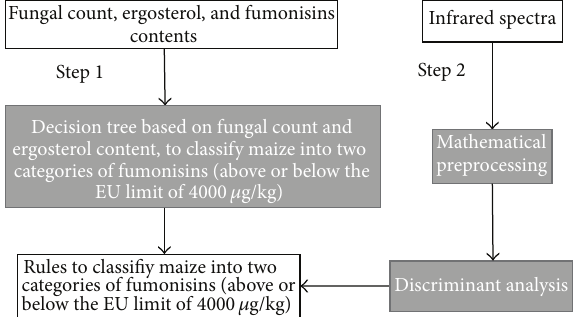
Figure 1: Procedure for classifying maize according to fumonisin